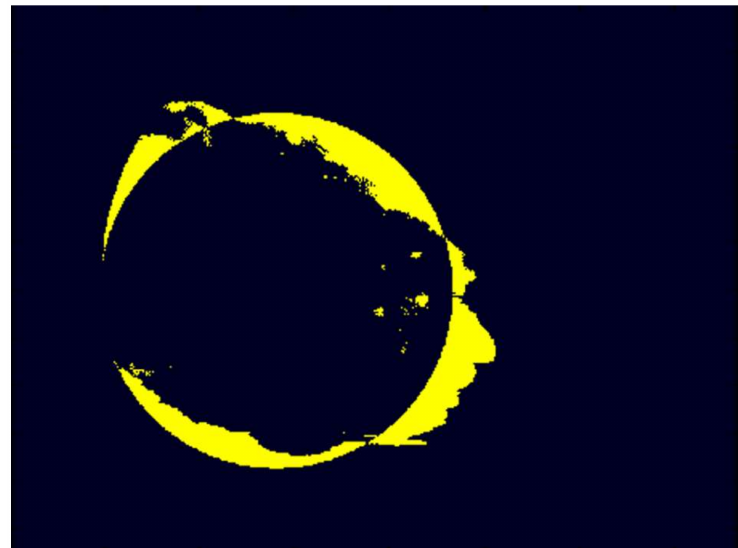
Figure 3. Result of the Boolean EXOR operation for the same image of the PH 2 database, previously segmented. The yellow zones are the non-overlapping pixels between the two areas.